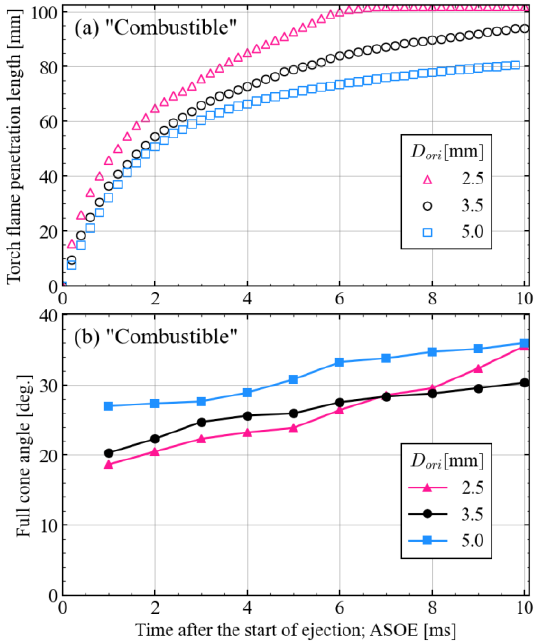
Fig. 16. Time history of (a) penetration, and (b) cone angle of different orifice diameter (D ori = 2.5, 3.5, 5.0 mm) under “combustible” condition In particular, the torch flame from D = 2.5 mm im- ori pinged on the chamber wall at as early as 6 ms ASOE.